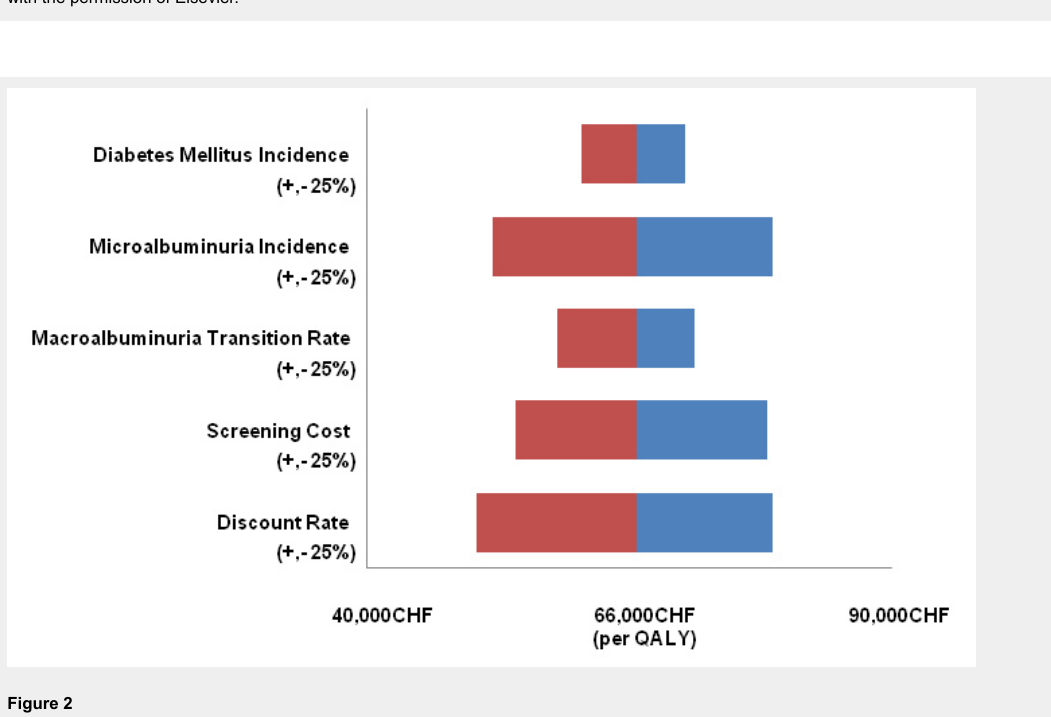
Figure 2 Sensitivity Analysis. One-way sensitivity analysis, which shows the impact of a change in key parameters of plus or minus 25%, depicted by red and blue bars, on the cost-effectiveness ratio of annual screening versus no screening of the full population, starting at age of 50